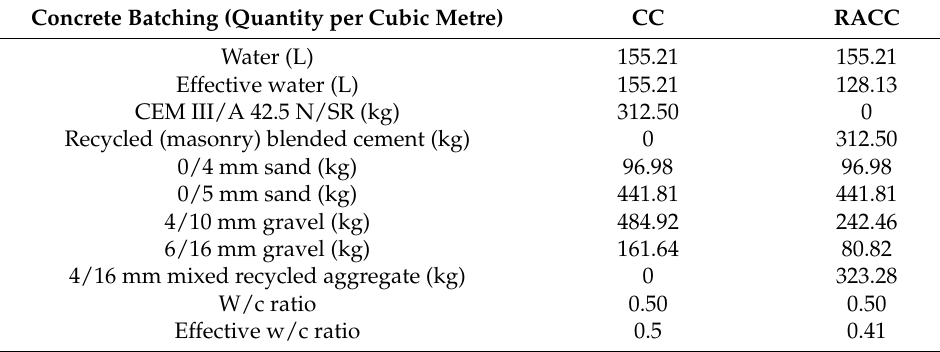
Table 8. Concrete batching (quantities per cubic